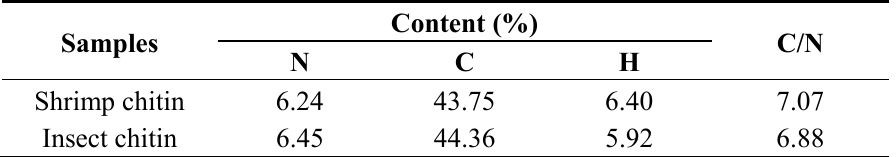
Table 3. The elemental analysis of chitin from shrimp and H. parallela and the corresponding degree of acetylation